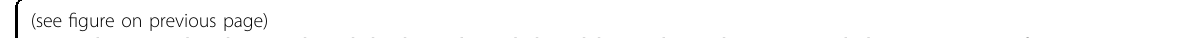
Fig. 1 Fbp2 was abundant in white skeletal muscle, and Fbp2 deletion changed energy metabolism. a Tissue-speci fi c gene expression patterns of Fbp1 and Fbp2 in WT mice analyzed by quantitative reverse transcription polymerase chain reaction (RT-PCR). ND Nondetected. n = 4 per group. b Tissue-speci fi c Fbp2 protein expression pattern in WT mice analyzed by immunoblotting. c Fbp2 gene expression in the soleus and extensor digitorum longus muscle of WT mice analyzed by quantitative RT-PCR. n = 3 per group. d Body composition analysis by the 1 H-nuclear magnetic resonance system including body weight, fat mass, and lean mass. n = 8 per group. e Weight of various skeletal muscles. n = 6 per group. f Locomotor activity, h whole-body O 2 consumption (VO 2 ), and j whole-body CO 2 production (VCO 2 ) of WT and Fbp2 KO mice during the 72-h analysis. n = 8 per group. 24 h, day and night time averages of g locomotor activity, i VO 2 , k VCO 2 . GAS gastrocnemius, TA tibialis anterior, QD quadriceps, EDL extensor digitorum longus. Data are expressed as the mean ± SEM. * P < 0.05, ** P < 0.01 by Student ’ s t -test for ( c – e , g , i , k ). ++ P < 0.01, +++ P < 0.001 by two-way analysis of variance (ANOVA) with post hoc analysis for ( f ) and # P < 0.05 by Student ’ s t-test at each time point for h and j . ns nonsigni fi